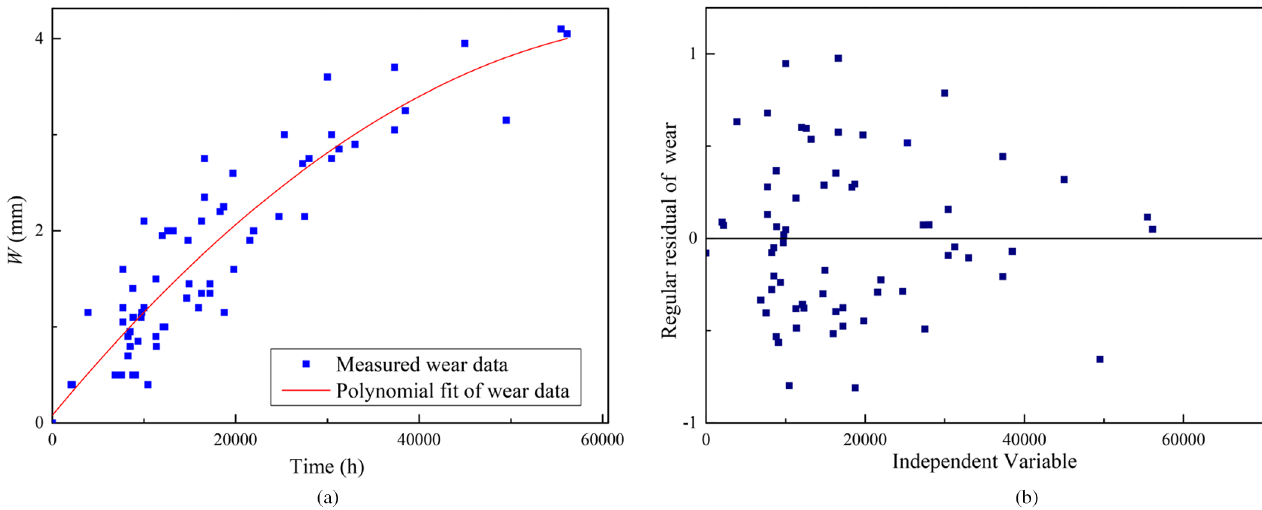
Fig. 4. The polynomial fi tting curve of the cylinder liner wear. (a) Polynomial fi tting. (b) The residual